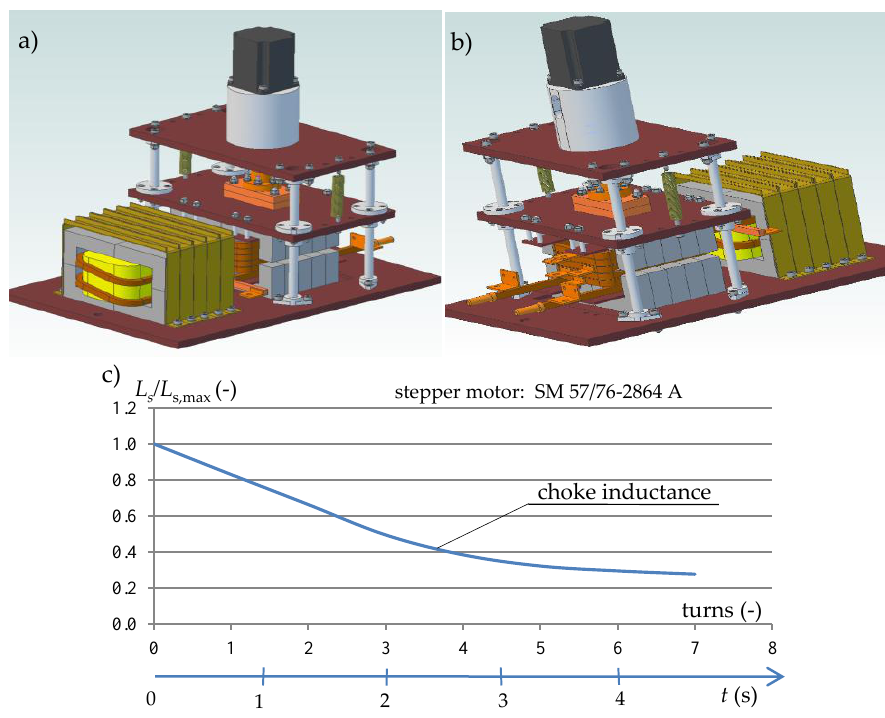
Figure 9. Structural model of the magnetic assembly with a stepper motor: ( a ) view from the transformer side, ( b ) view from the choke side, and ( c ) choke inductance change as a function of stepper motor turns.